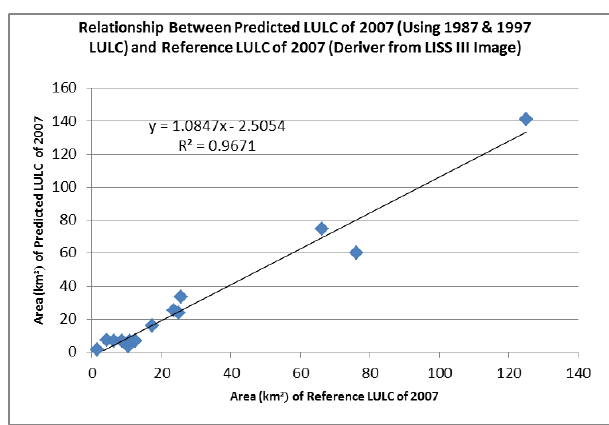
Figure 6. Relationship between predicted LULC of 2007 (using 1987 & 1997 LULC image) and LULC derived from LISS III image of